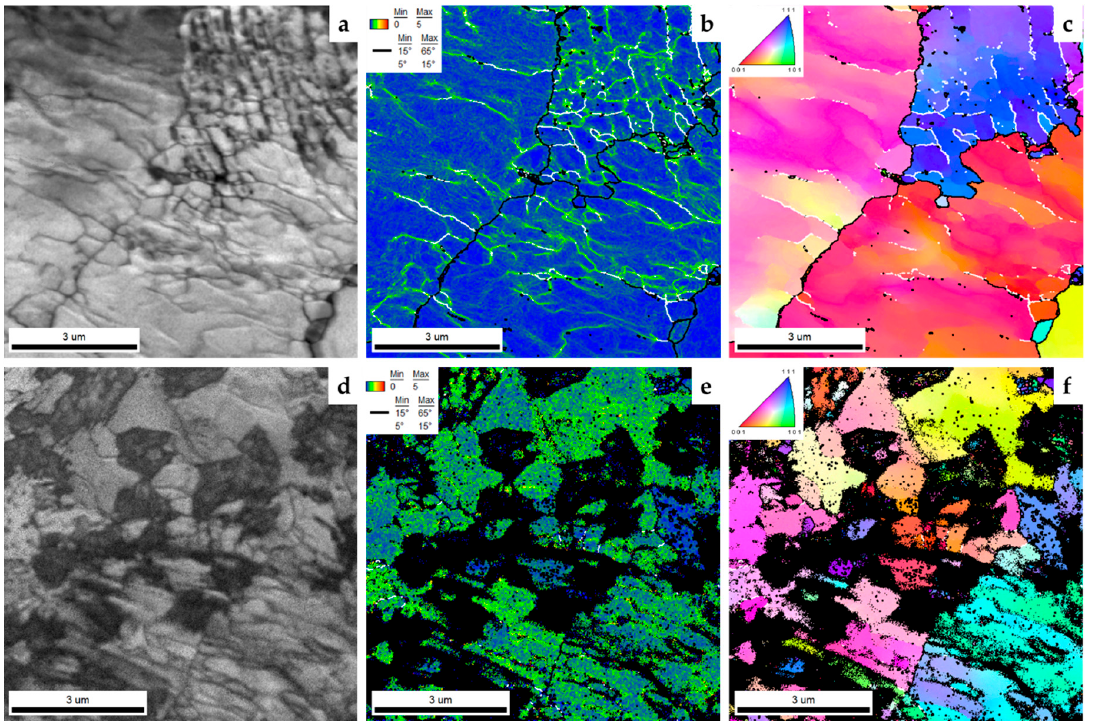
Figure 10. ( a ) IQ map of the CH sample obtained by transmission Kikuchi diffraction (TKD). ( b ) KAM map of the same area showing the result of dislocations and their density and the LAGBs (white) and HAGBs (black). ( c ) IPF map of the same area showing the misorientations within the ferrite grains caused by the dislocations. LAGBs and HAGBs appear in the same colors. The same maps are shown for the UFH sample in ( d – f ).